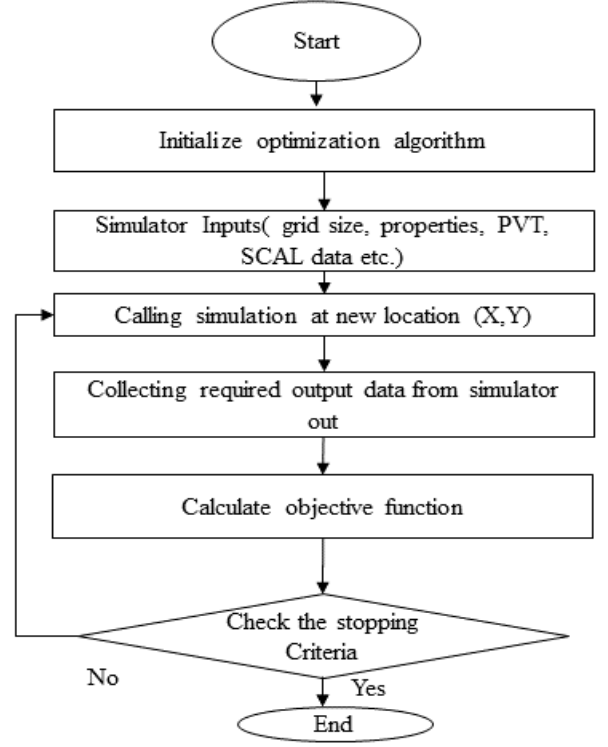
Figure 1. A general flow chart for searching the maximum net profit value.